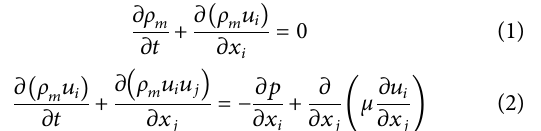
FIGURE 3 | Time-averaged lift and draft coef fi cients against mesh